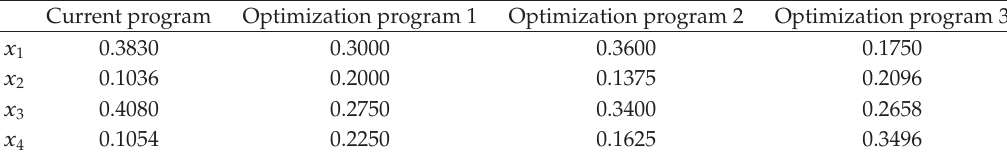
Table 3: Control